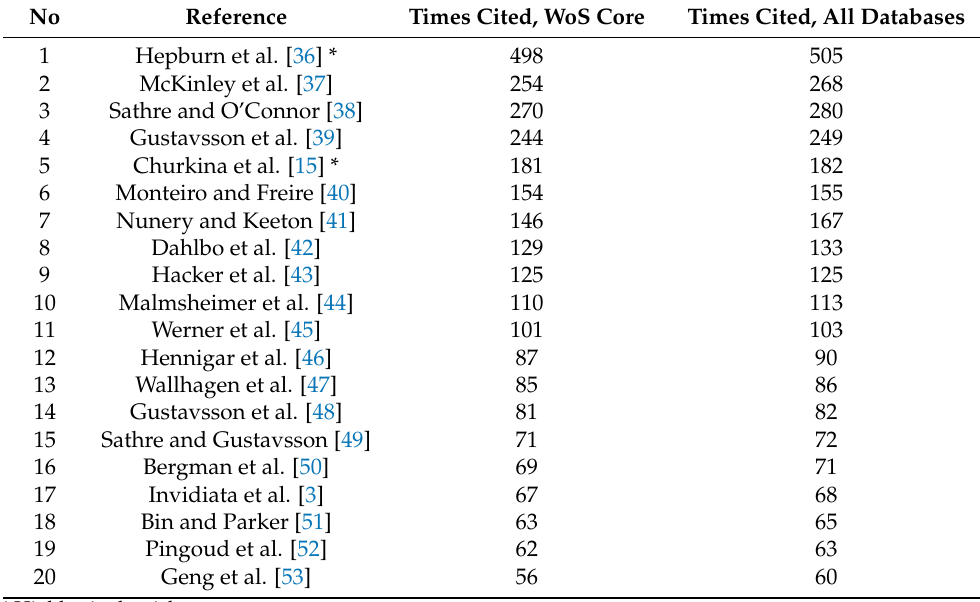
Table 3. Top twenty highly cited articles.